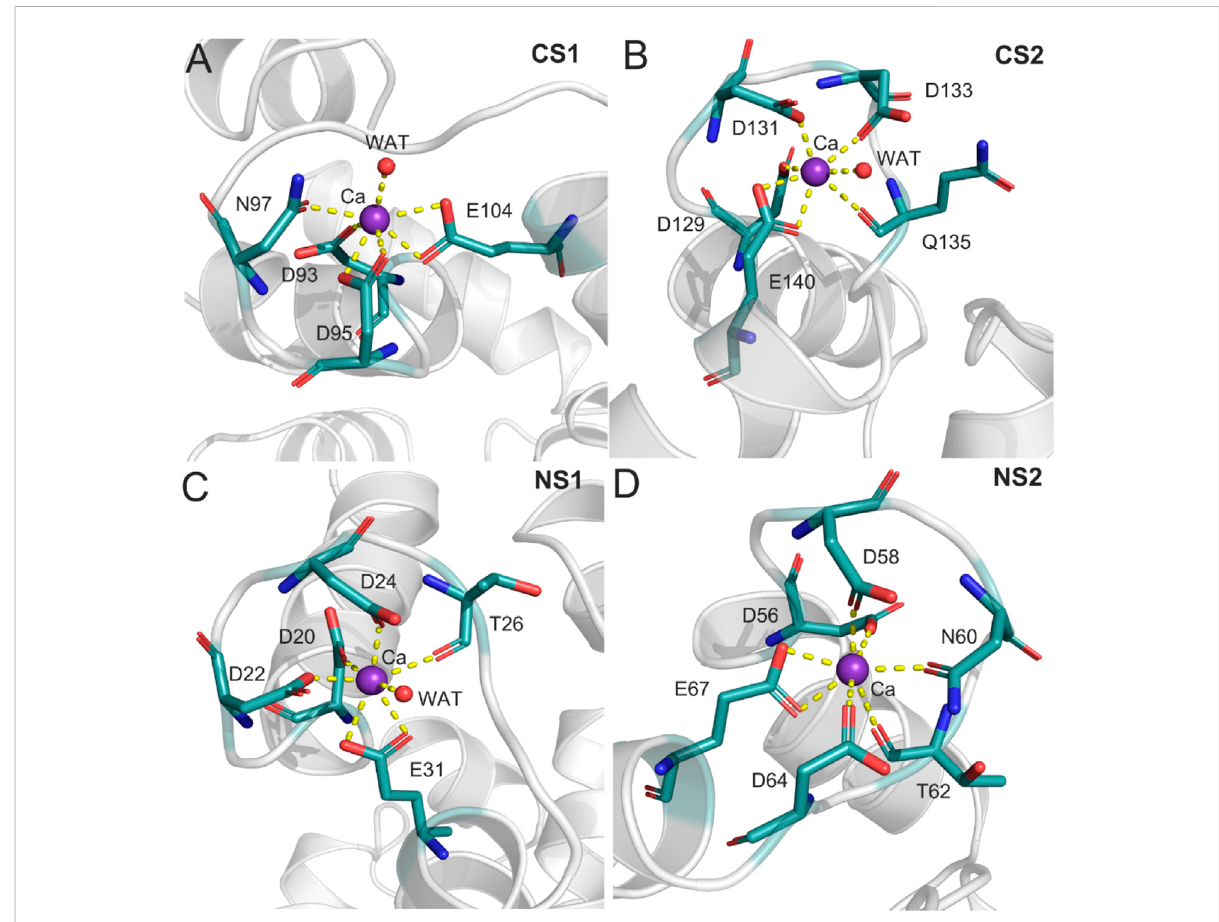
The detailed coordination interactions for the Ca 2+ in the CS1 (A) , CS2 (B) , NS1 (C) , and NS2 (D) binding sites in the Ca 2+ -bound